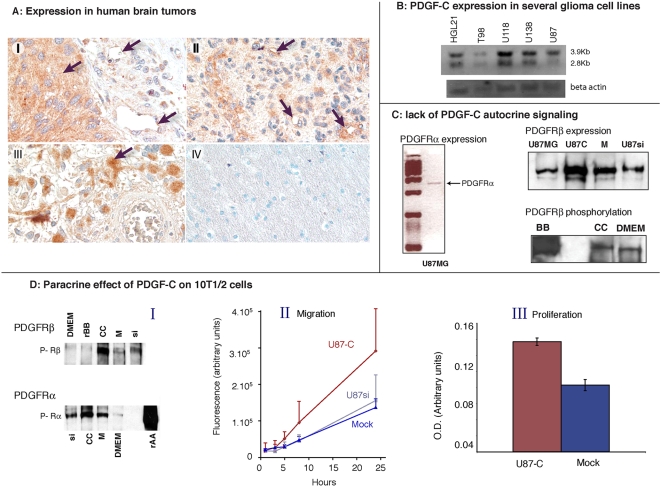
PDGF-C expression in human gliomas – autocrine & paracrine signaling.A: Expression of PDGF-C in human samples of gliomas. 27 samples of Grade IV glioma (Tissue Microarrays, kind gift from Dr. David Louis, MGH) were screened for expression of PDGF-C using immunohistochemistry (PDGF-C monoclonal antibody from R&D, used at 1/100). 23 out of 27 specimens expressed PDGF-C in tumor cells and/or in the peri-vascular area. Panels I, II and III are 3 different patients; panel IV is normal brain tissue present on the same array. In I and III positive tumor cells can clearly be identified; positive endothelium is evident in I and II, and perivascular cells also stain in panel II. In all panels, brown color (DAB) shows positive labeling for PDGF-C while blue (hematoxilin) stains nuclei. B: PDGF-C RNA expression in several common glioma cell lines. We chose U87 since it has a relatively low level expression compared to other cell lines and is thus amenable to downreglation. C: Lack of autocrine effect of PDGF-C on U87MG cells. Qt-RTPCR of PDGFRα in U87 cells shows that RNA is present, but there is no protein detectable by Western blot (not shown). PDGFRβ protein expression in parental (U87MG), PDGF-C overexpressor (U87-C), Mock-transfected (M) or ShRNAi cells (si). PDGFRβ phosphorylation. Cells were treated overnight with one of the following: recombinant PDGF-B (rBB, positive control); conditioned medium from cells overexpressing PDGF-C (CC); fresh DMEM culture medium (DMEM). PDGF-C did not induce phosphorylation above the baseline level. D: Effect of PDGF-C on 10T1/2 myofibroblasts. Panel I, Top: Phosphorylation of PDGFRβ. Cells were stimulated overnight with fresh DMEM culture medium (DMEM), recombinant PDGFBB (rBB; positive control), U87-C conditioned medium (CC), or conditioned medium from mock-transfected cells (M). PDGF-C did not stimulate this receptor. Bottom: phosphorylation of PDGFRα on 10T1/2 cells in culture. Cells were stimulated overnight with conditioned medium from U87si (si), U87-CC (CC), mock transfected cells (M), or fresh DMEM culture medium (DMEM). Recombinant PDGFAA was used as a positive control (rAA). The phosphorylation induced by the mock and U87si media is likely due to PDGF-A produced by these cells. Treatment of 10T1/2 cells with PDGF-C conditioned medium results in faster migration (Boyden chamber assay; panel II) and proliferation (WST-1 assay; panel III).